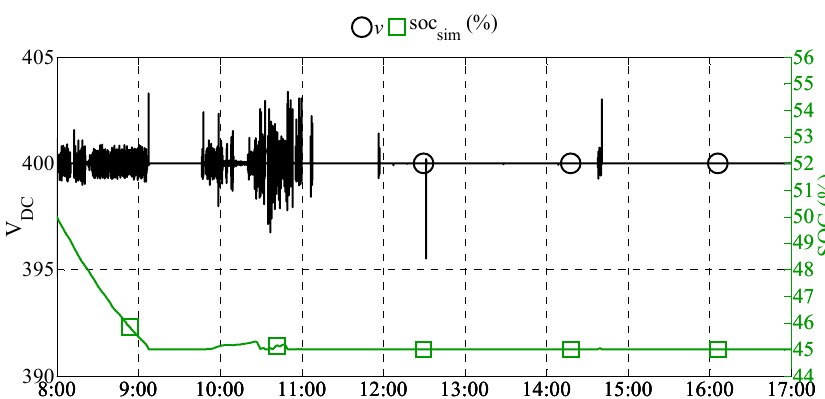
Figure 8. DC bus voltage and the state of charge evolution.